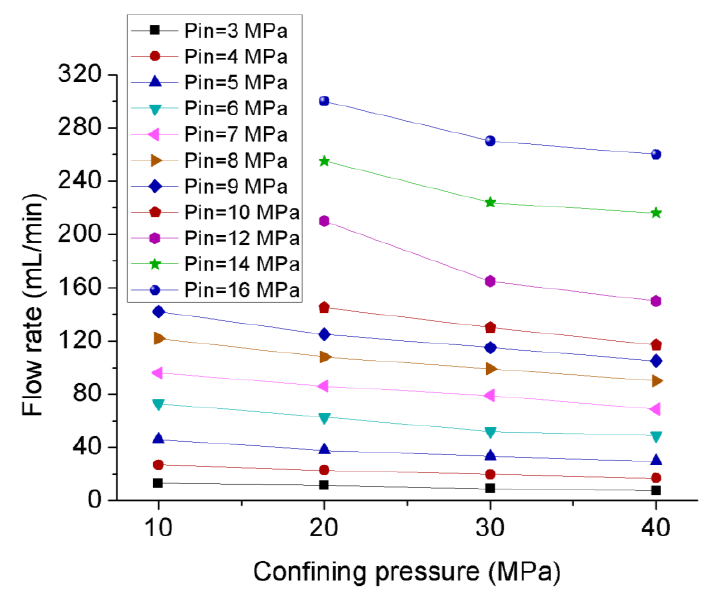
Figure 15. Relationship between permeability of siltstone at different confining pressures.